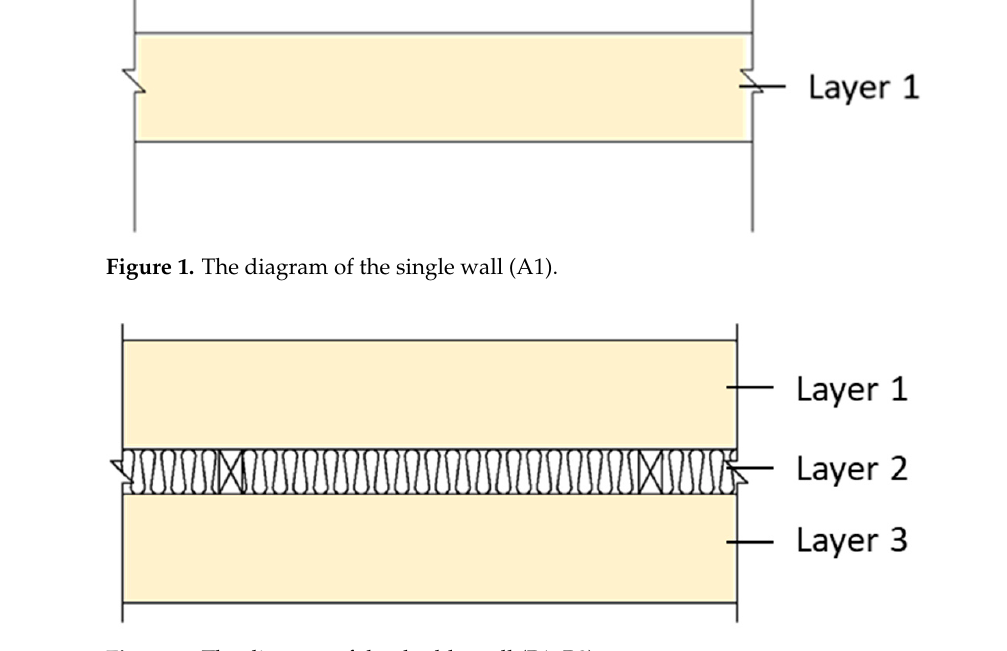
Figure 2. The diagram of the double wall (B1–B8).